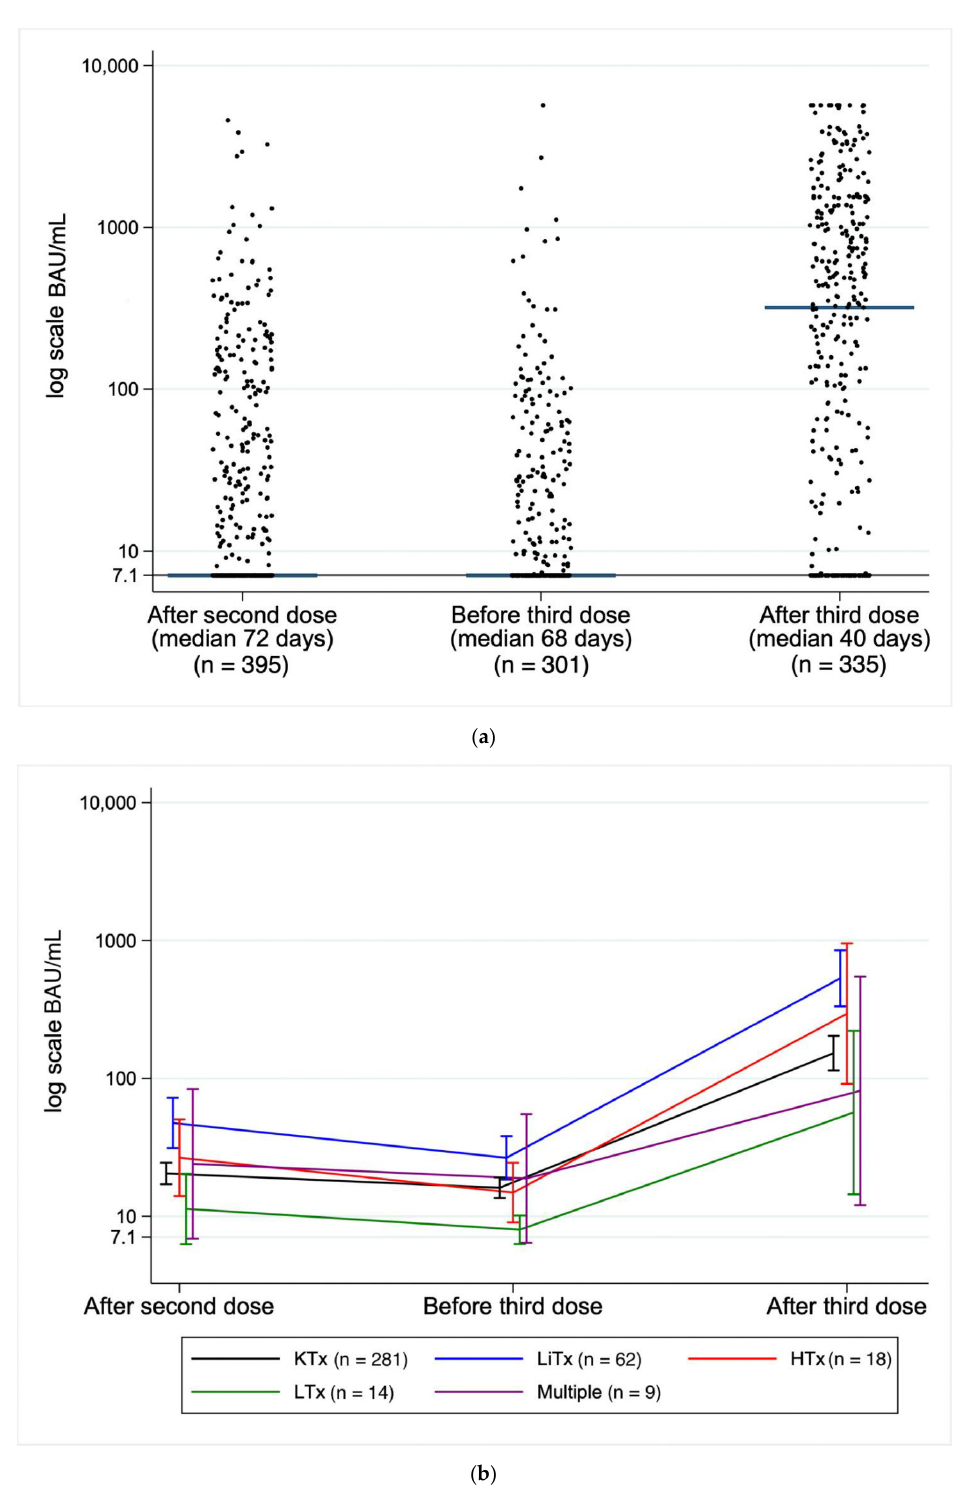
Figure 1. ( a ): Anti-SARS-CoV-2 antibody after the second and the third dose of a SARS-CoV-2 mRNA vaccine among solid organ transplant recipients, depicted on a log-scale. Median after second dose: 7.1 (IQR 7.1–73.2) ; Median after third dose: 319.5 (IQR 17.2–1244.7). ( b ): Anti-SARS-CoV-2 antibody titers to SARS-CoV-2 vaccine correlated to transplant. Transplants: KTx (kidney), LiTx (liver), HTX (heart), LTx (lung), Multiple. From after the second dose to before third dose mean increase/decrease: − 74.4 BAU/mL (95% CI: − 208.9–60.2). From after the second dose to after the third dose mean increase/decrease: +831.2 BAU/mL (95% CI: